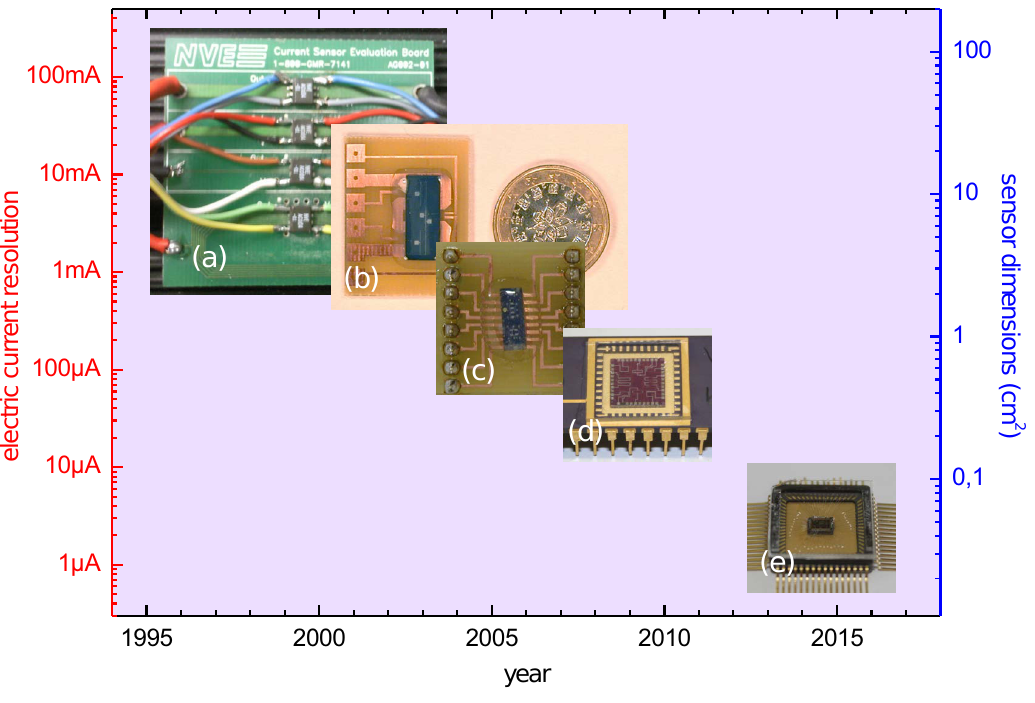
Figure 10. Historical evolution of GMR based current sensors regarding size and current resolution: ( a ) NVE evaluation board; ( b ) current sensor from [34]; ( c ) current sensor from [43]; ( d ) current sensor from [11]; ( e ) current sensor from [29].